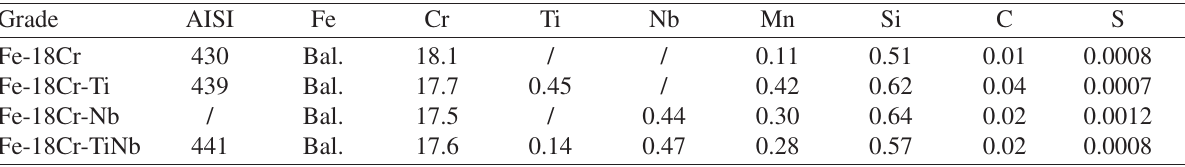
Table 1. Chemical composition of the ferritic grades (weight